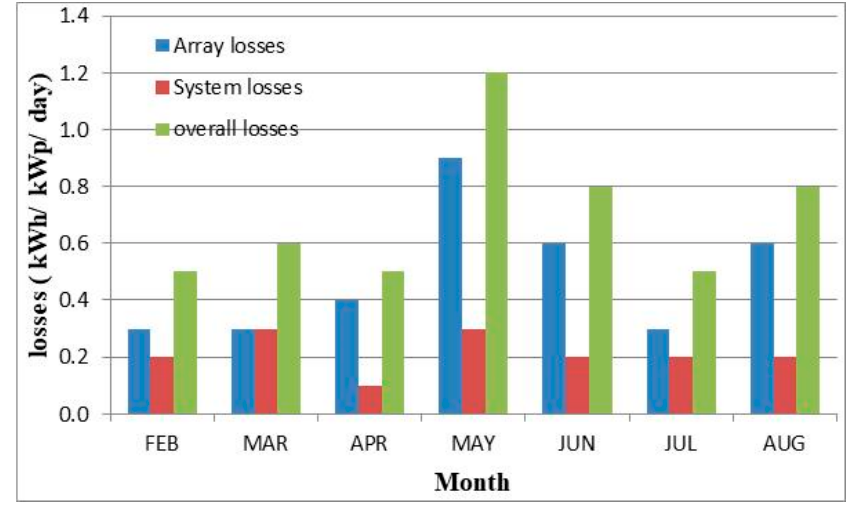
Figure 8. Average daily array capture, system and overall losses.